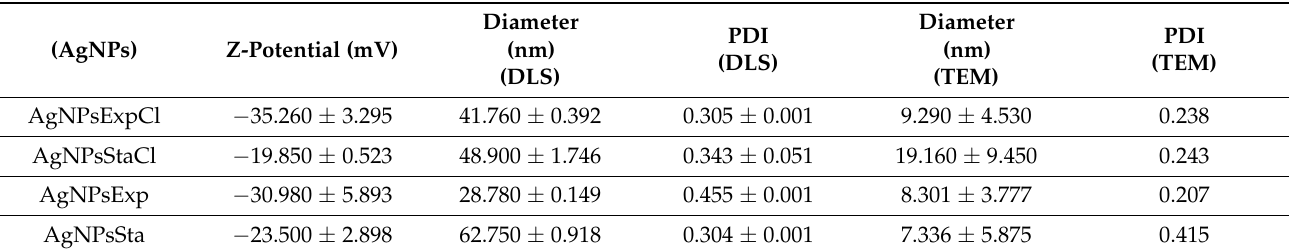
Table 1. Summary of the AgNPs’ characterization.